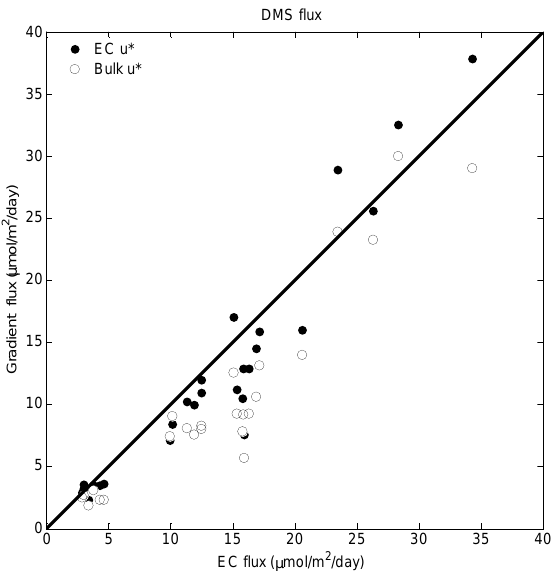
Figure 6. Direct comparison of DMS flux measured by GF and EC techniques, using different evaluations of u ∗ for GF, from direct EC measurements (black filled circles) and from bulk formulae (open